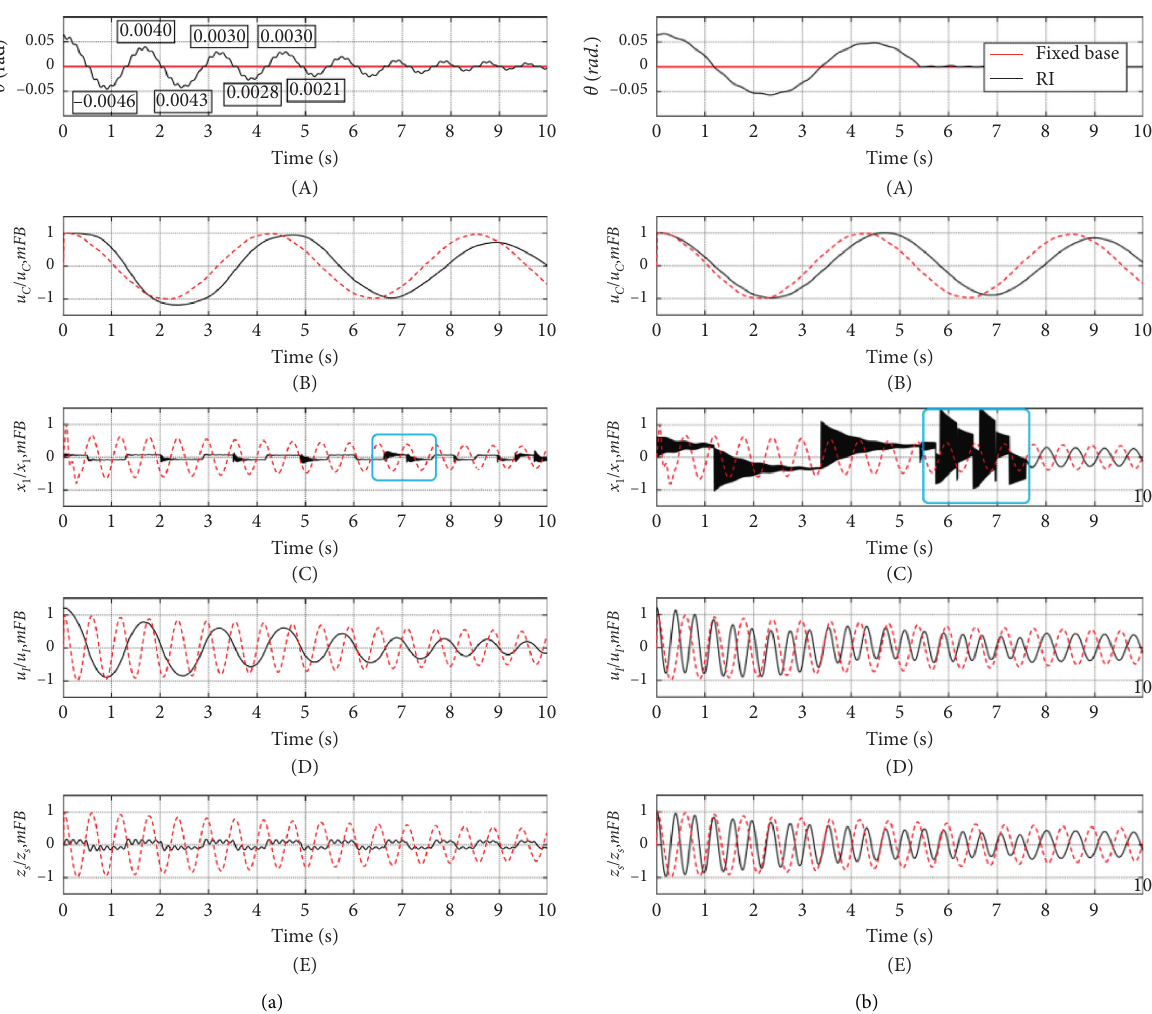
Figure 9: Normalized time histories of free (A) rocking, (B) convective, (C) wall flexibility, (D) impulsive, and (E) shaft top end responses for a sample structure with “first case of RI-C1” (a) and “second case of RI-C2” (b) to an initial tilt angle.